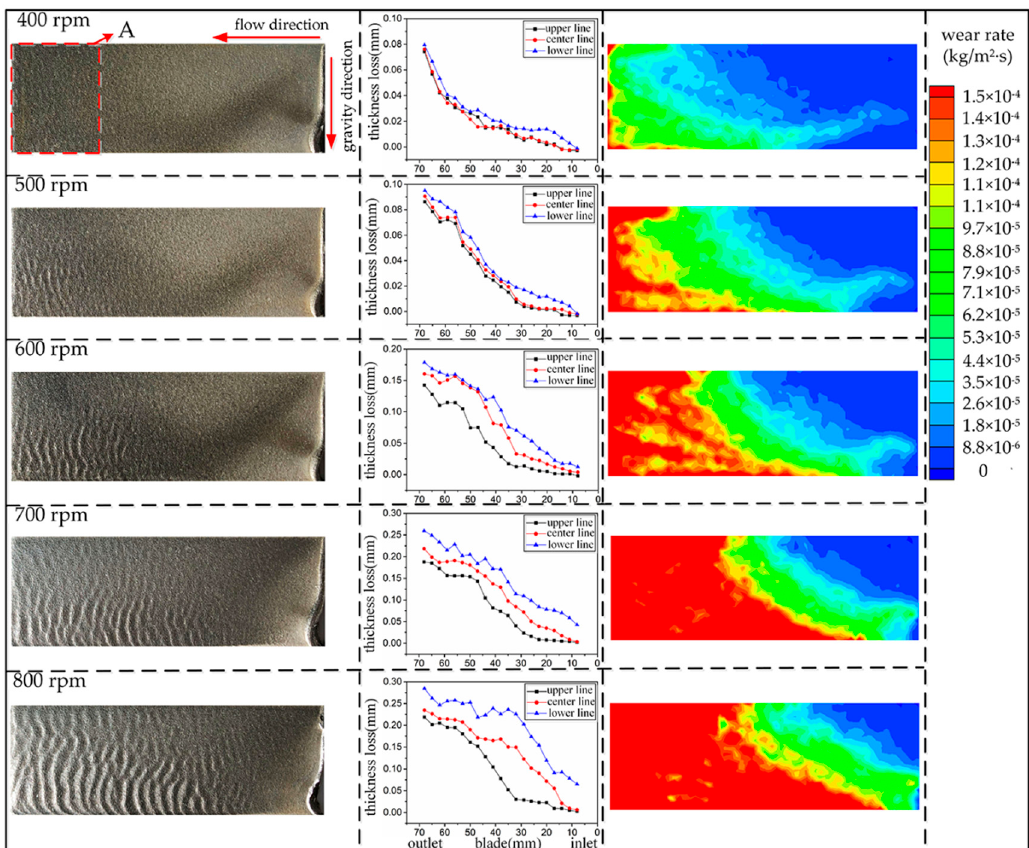
Figure 12. Abrasion diagram of the working surfaces of blades at different rotation speeds and an 8% particle mass concentration.